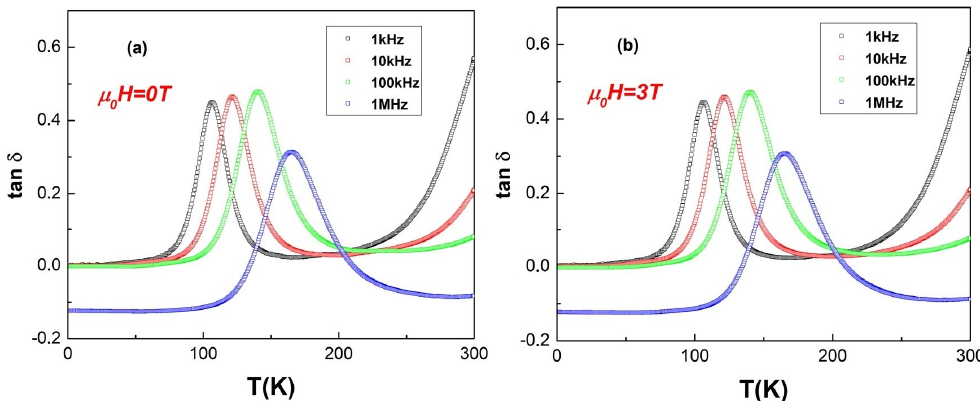
Figure 9. ( a ) Variation of tan δ as a function of temperature for the BiMn 2 O 5 sample in the absence of a magnetic field. ( b ) Variation of tan δ in the presence of a magnetic field (H = 3 tesla) at different frequencies.